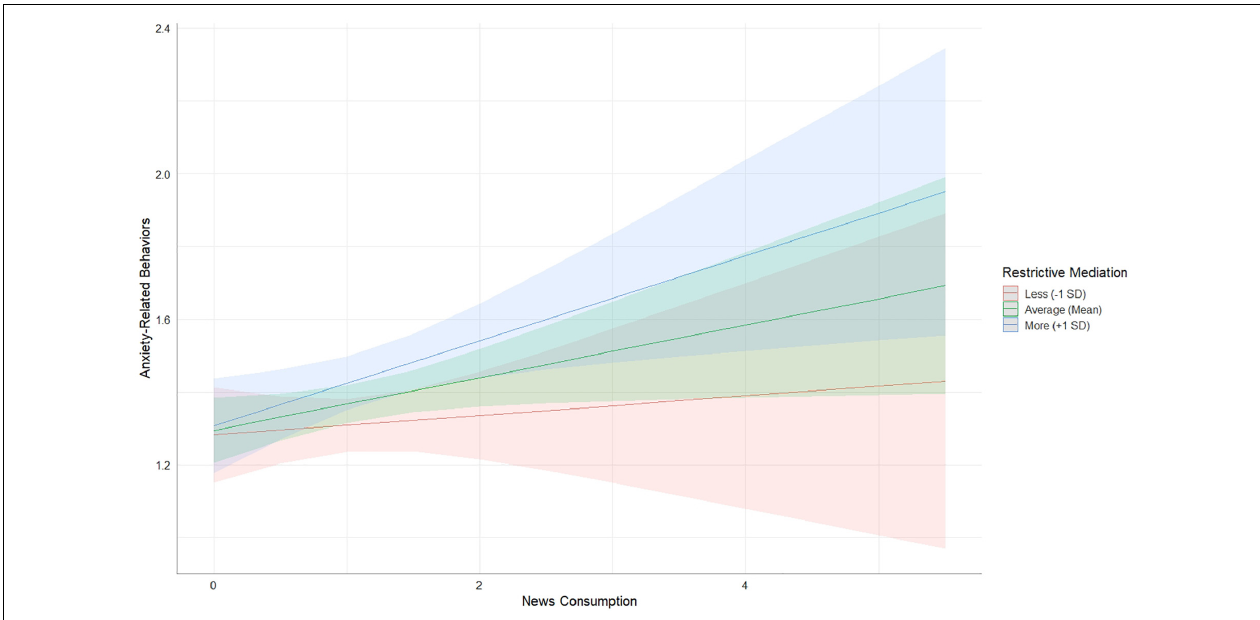
FIGURE 3 | Interaction between news consumption and restrictive mediation on anxiety-related behaviors. To interpret and plot the interaction effects that emerged from the main analysis, the parental mediation measure was split into 3 levels of restrictive mediation (–1 SD, mean, and + 1 SD). This figure was created with package sjPlot (Lüdecke,